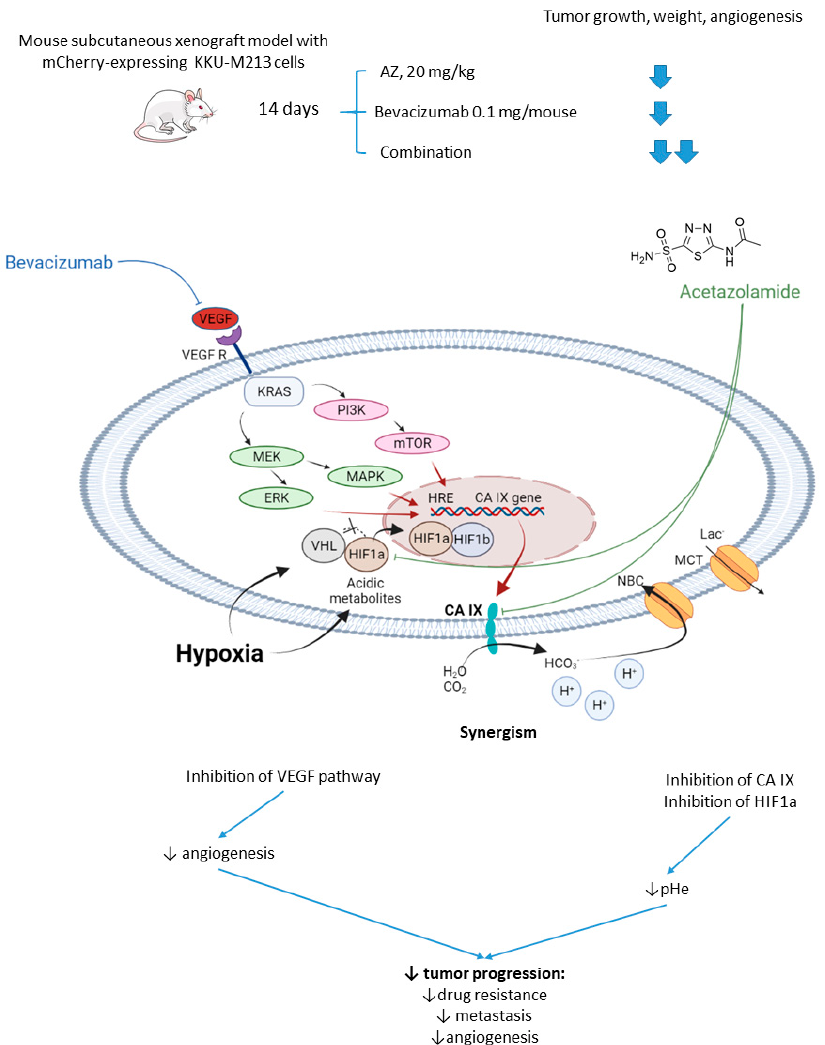
Figure 5. Graphical outline of the study on AZ+bevacizumab combination reported by Vaeteewoot- tacharn et al. and a summary on the hypothesized molecular interactions resulting in synergistic action of the drugs